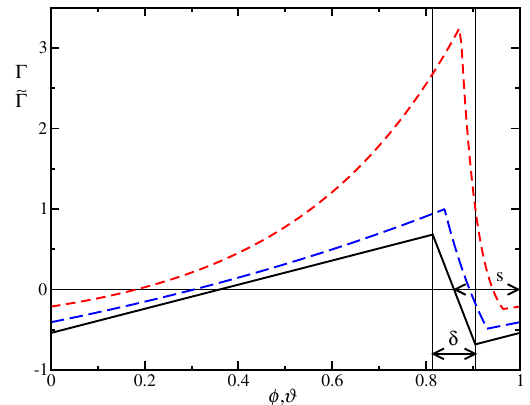
Þ according to Eq. (2) for FIG. 1. Phase response curve Γ ð ϕ i the standard parameter values b 1 ¼ 1 . 5 , s ¼ 0 . 14 , and δ ¼ 0 . 1 (solid line). The short- and long-dashed curves correspond to the ~ Γ effective PRC [see Eq. (13) and corresponding text] obtained ¼ 0 . 8 and ω ¼ ω ¼ 2 , respectively (with for ω ¼ ω min max g ¼ 0 . 8